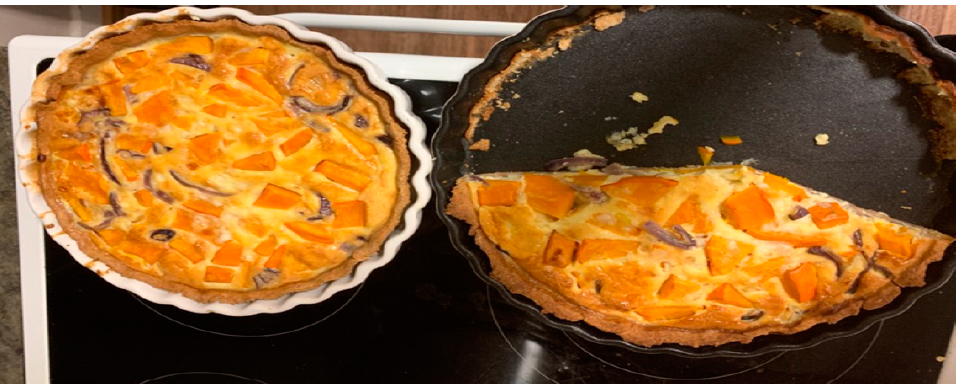
Figure 1. Flan prepared by a girl and her mother (photo sent by family between the cooking